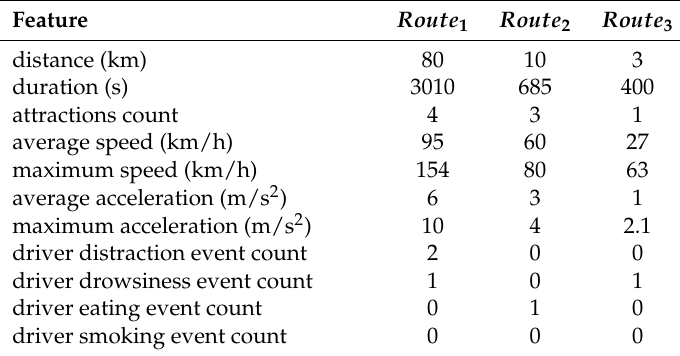
Table 1. Dataset route example.